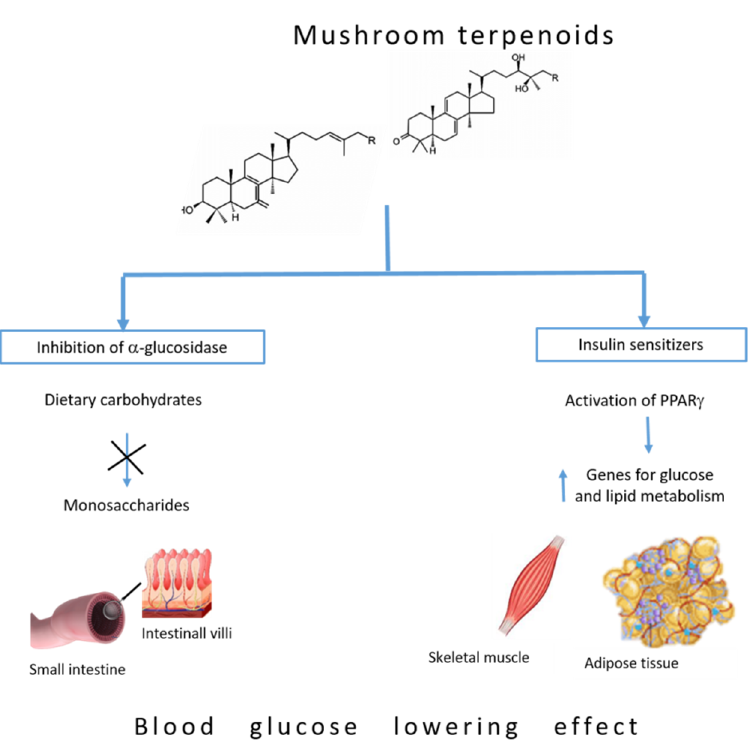
Figure 3. Anti-hyperglycemic mechanisms of mushroom terpenoids in different tissues involved in glucose homeostasis. PPAR-γ: Peroxisome proliferator-activated receptors γ.